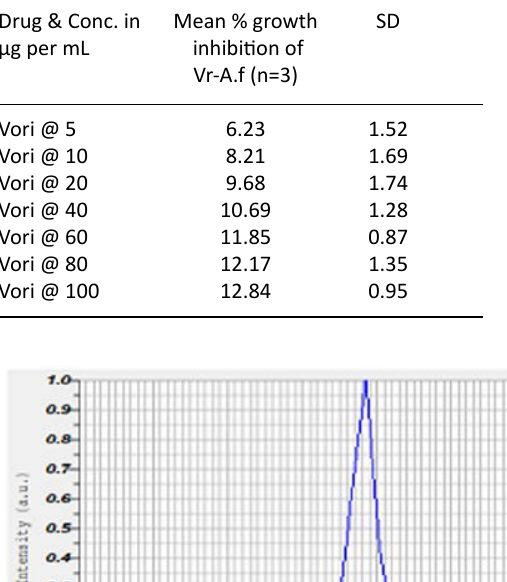
Table 3. Validation of resistant fungal strains: The resistant fungal strain, Aspergillus niger and Candida glabrata was validated by using Voriconazole (vori) and Fluconazole (Flu) respectively. The mean percentage growth inhibition of fungi was measured at 5, 10, 20, 40, 60, 80 and 100 µg/ml Drug & Conc. in Mean % growth μg per